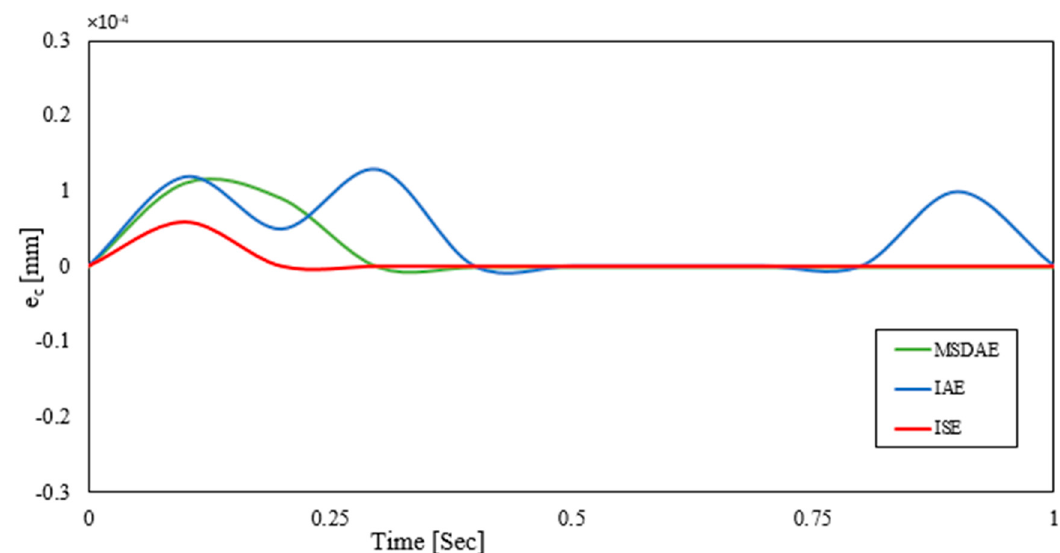
Figure 5. Contour error produced in linear and non-linear contour tracking using gain optimiza- tion through fitness functions.